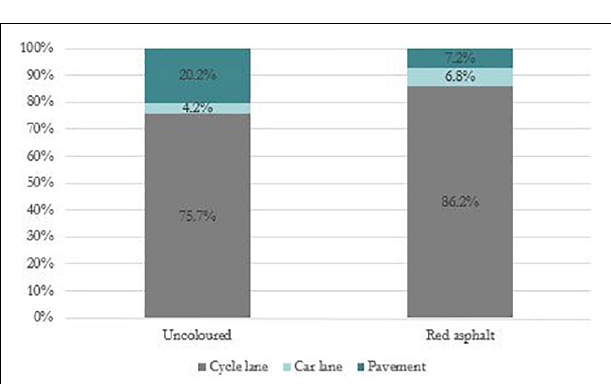
FIGURE 3 | Percentage of cars stopping in- versus outside of the cycle lane before ( n = 244) and after ( n = 252) the implementation of red asphalt.